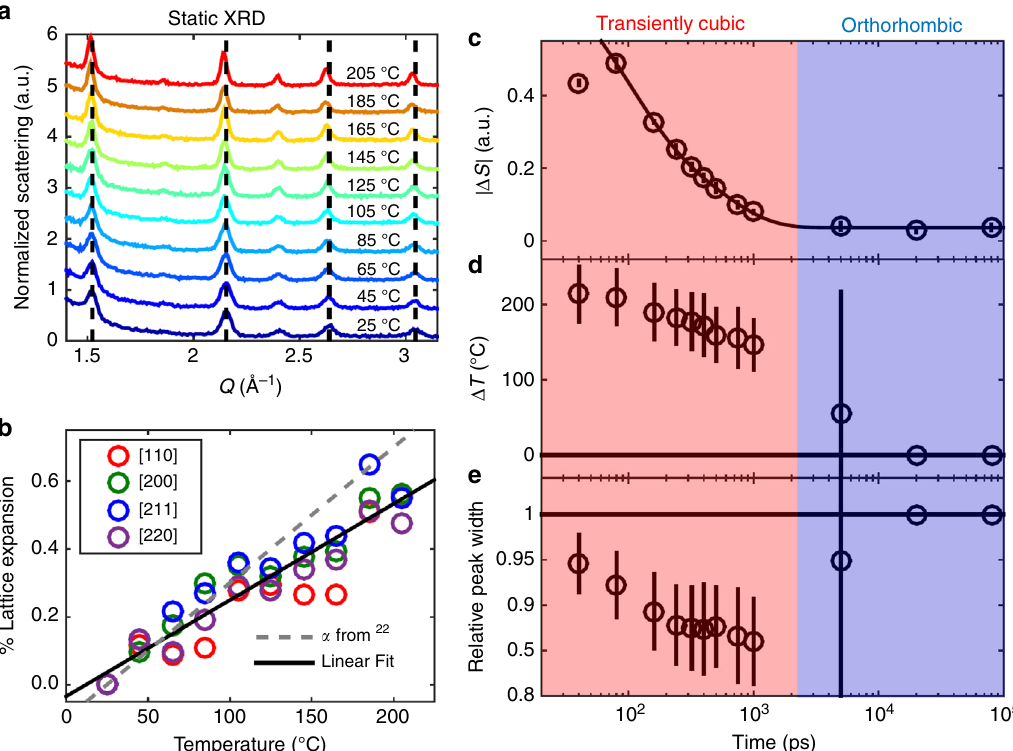
Fig. 3 Temporal evolution of NC lattice. a Temperature-dependent XRD with black dashed lines to emphasize the room temperature peak position. b Expansion of lattice planes from static experiments versus temperature along with a linear fi t which suggests a thermal expansion coef fi cient of 28.4 ± 3.5 × 10 − 6 K − 1 along with the bulk thermal expansion coef fi cient from Stoumpos et al. 22 . c Integrated absolute change in scattering signal for NCs versus time under a fl uence of 4.8 mJ cm − 2 along with a biexponential fi t. Error bars indicate standard deviation in the measurement. d Change in NC temperature versus time as calculated from our temperature-dependent XRD measurements. Error bars indicate 95% con fi dence intervals from our fi tting algorithm. e Change in relative diffraction peak width (relative to unexcited sample) as calculated from fi tting the TR-XRD pattern. Error bars indicate 95% con fi dence intervals from our fi tting algorithm